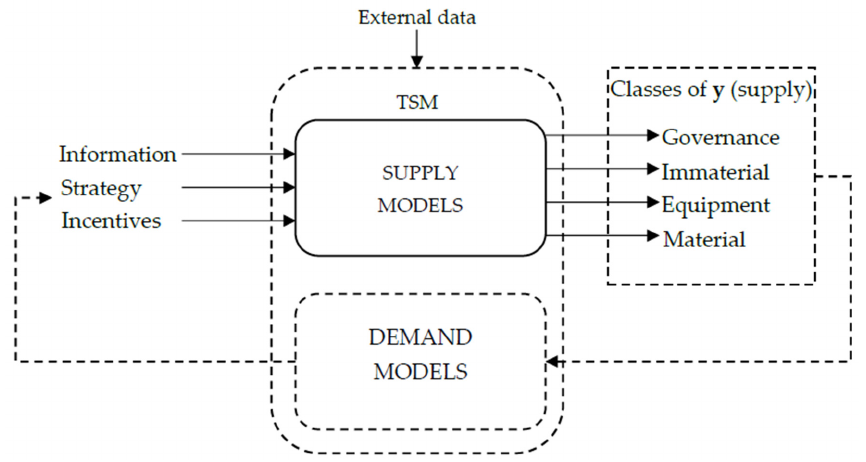
Figure 7. Supply models inside the TSM framework.